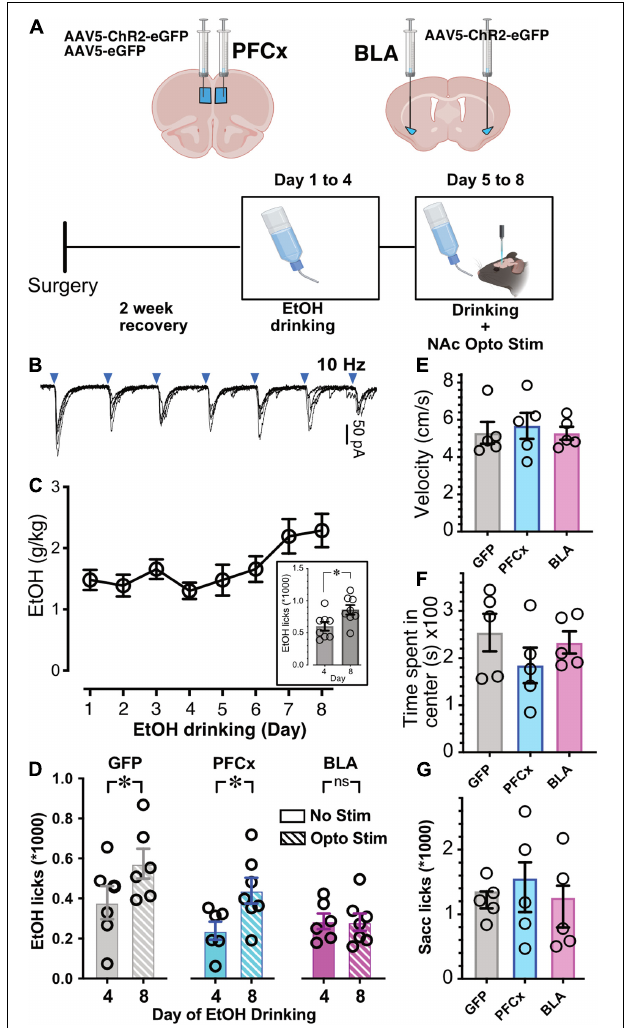
FIGURE 7 | Effects of optogenetic activation of PFCx or BLA inputs on EtOH drinking. (A) Schematic illustrating the sites of bilateral injections and the timeline of the behavioral experiments. (B) Synaptic responses to 10 Hz light stimulation of PFCx afferents. Blue triangles indicate time of